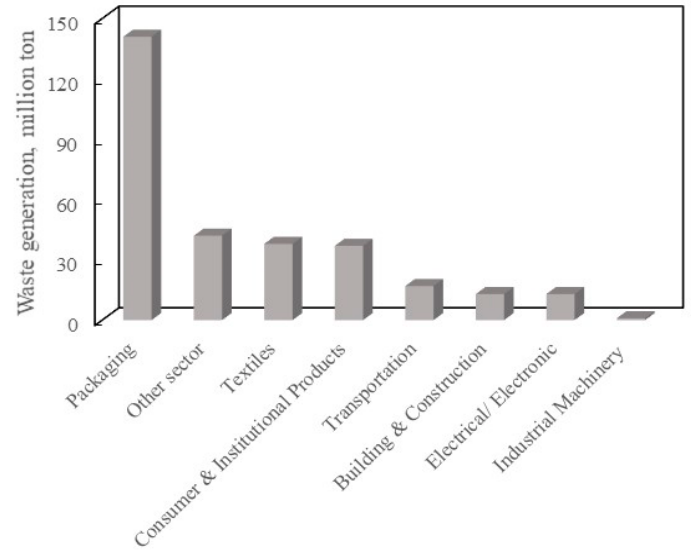
Figure 1. Global plastic waste generation by industrial sector in 2015 [2].